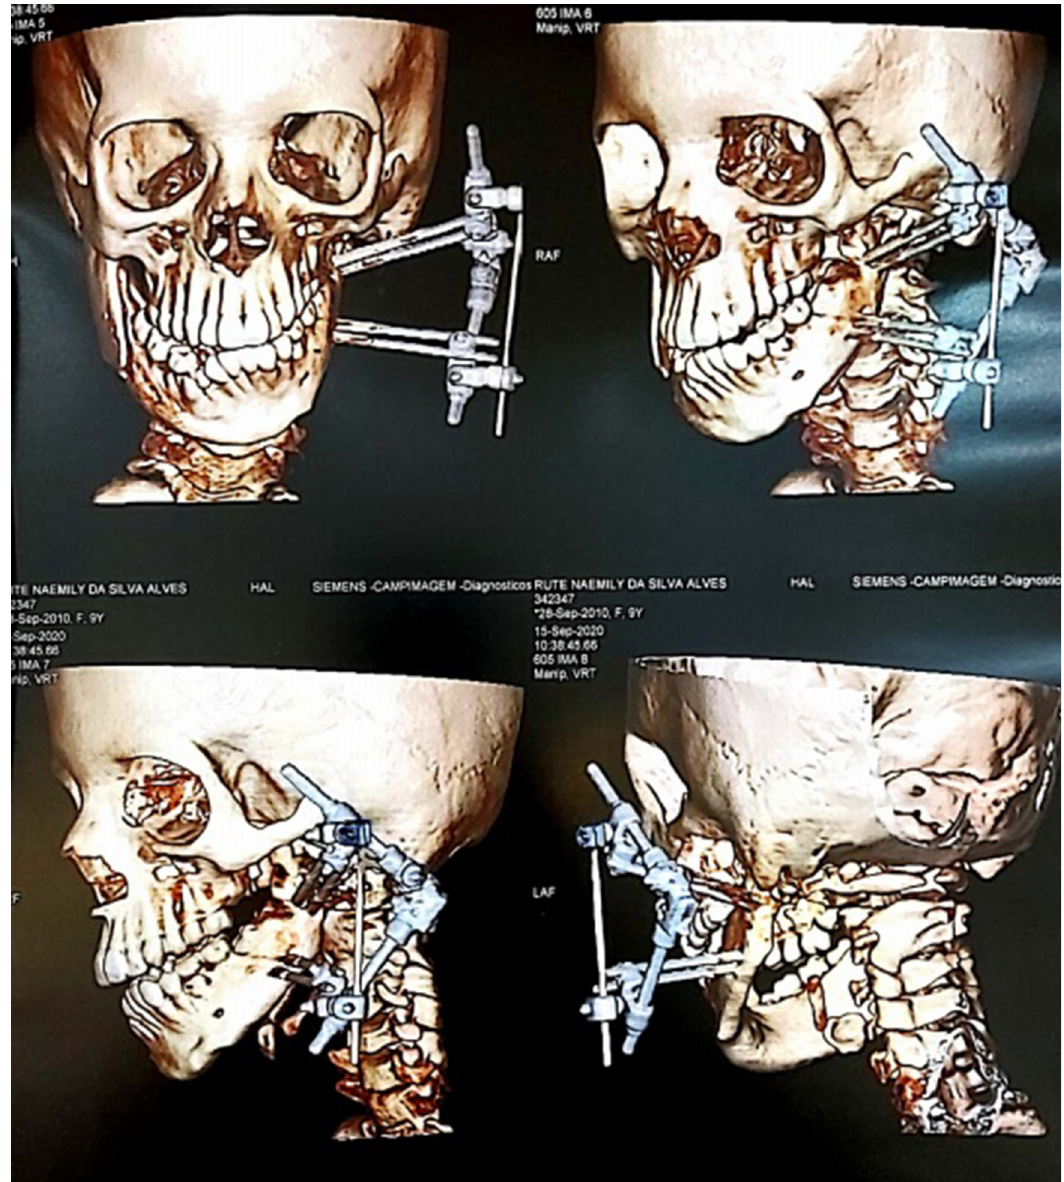
Fig. 7. Postoperative tomography. Possible to notice the distractor in